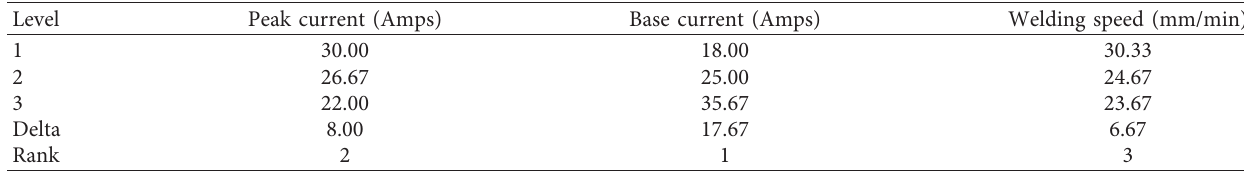
Figure 8: (a) Contour plot of tensile strength with respect to peak current and base current. (b) Contour plot of tensile strength with respect to base current and welding speed. (c) Contour plot of tensile vs. welding speed and peak current. Table 11: Response table for means (impact strength) (larger is better).